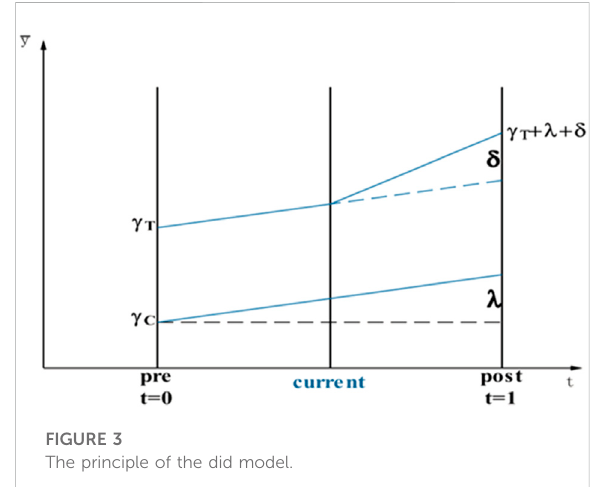
FIGURE 3 The principle of the did